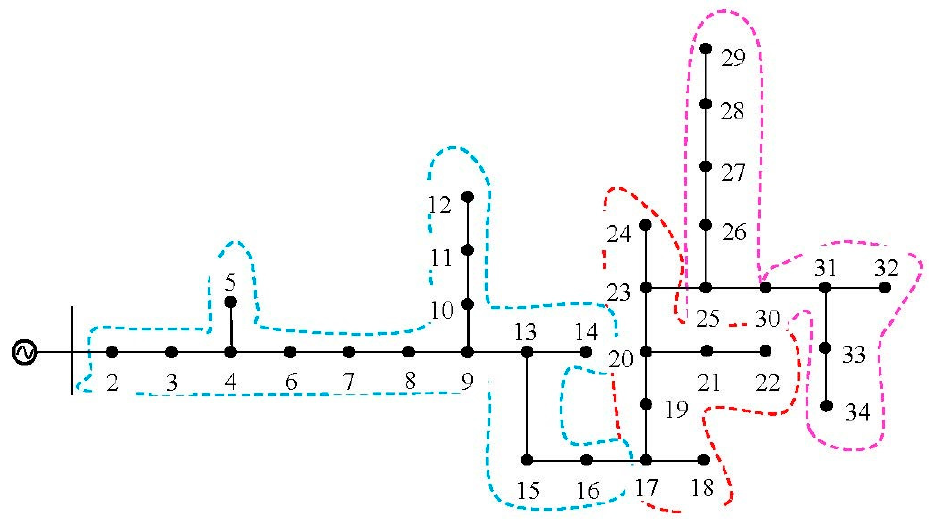
Figure 9. Network zoning into 3 microgrids. Which each zone in separated with different colors.